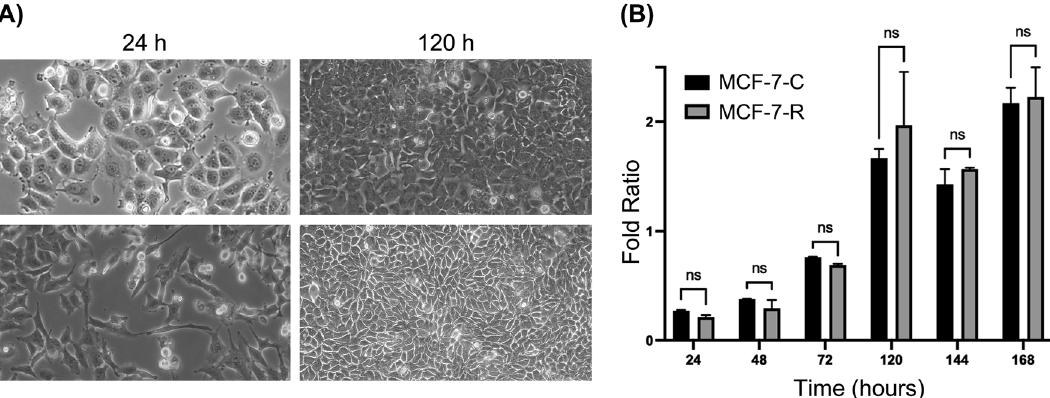
Figure 2: DAPT resistance induces morphological changes in MCF-7 cells. (A) Light microscopy images of MCF-7 cells resistant to IC 200 DAPT treatment (MCF-7-R) and DMSO-treated control cells (MCF-7-C) were taken at 24 h and 120 h after DAPT and DMSO treatments, respectively. (Scale bar: 50 μ m). (B) Viability of MCF-7-R and MCF-7-C cells cultured in drug-free media at di ff erent time points. Data represents the means and ± SD of two independent experiments (ns: not signi fi